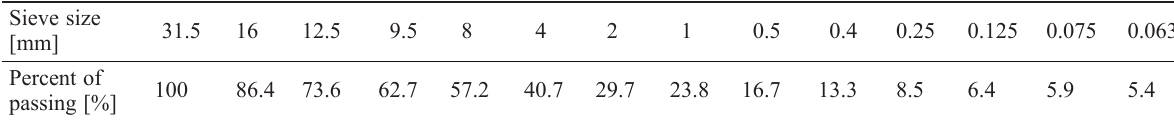
Table 1. Gradation of the aggregates